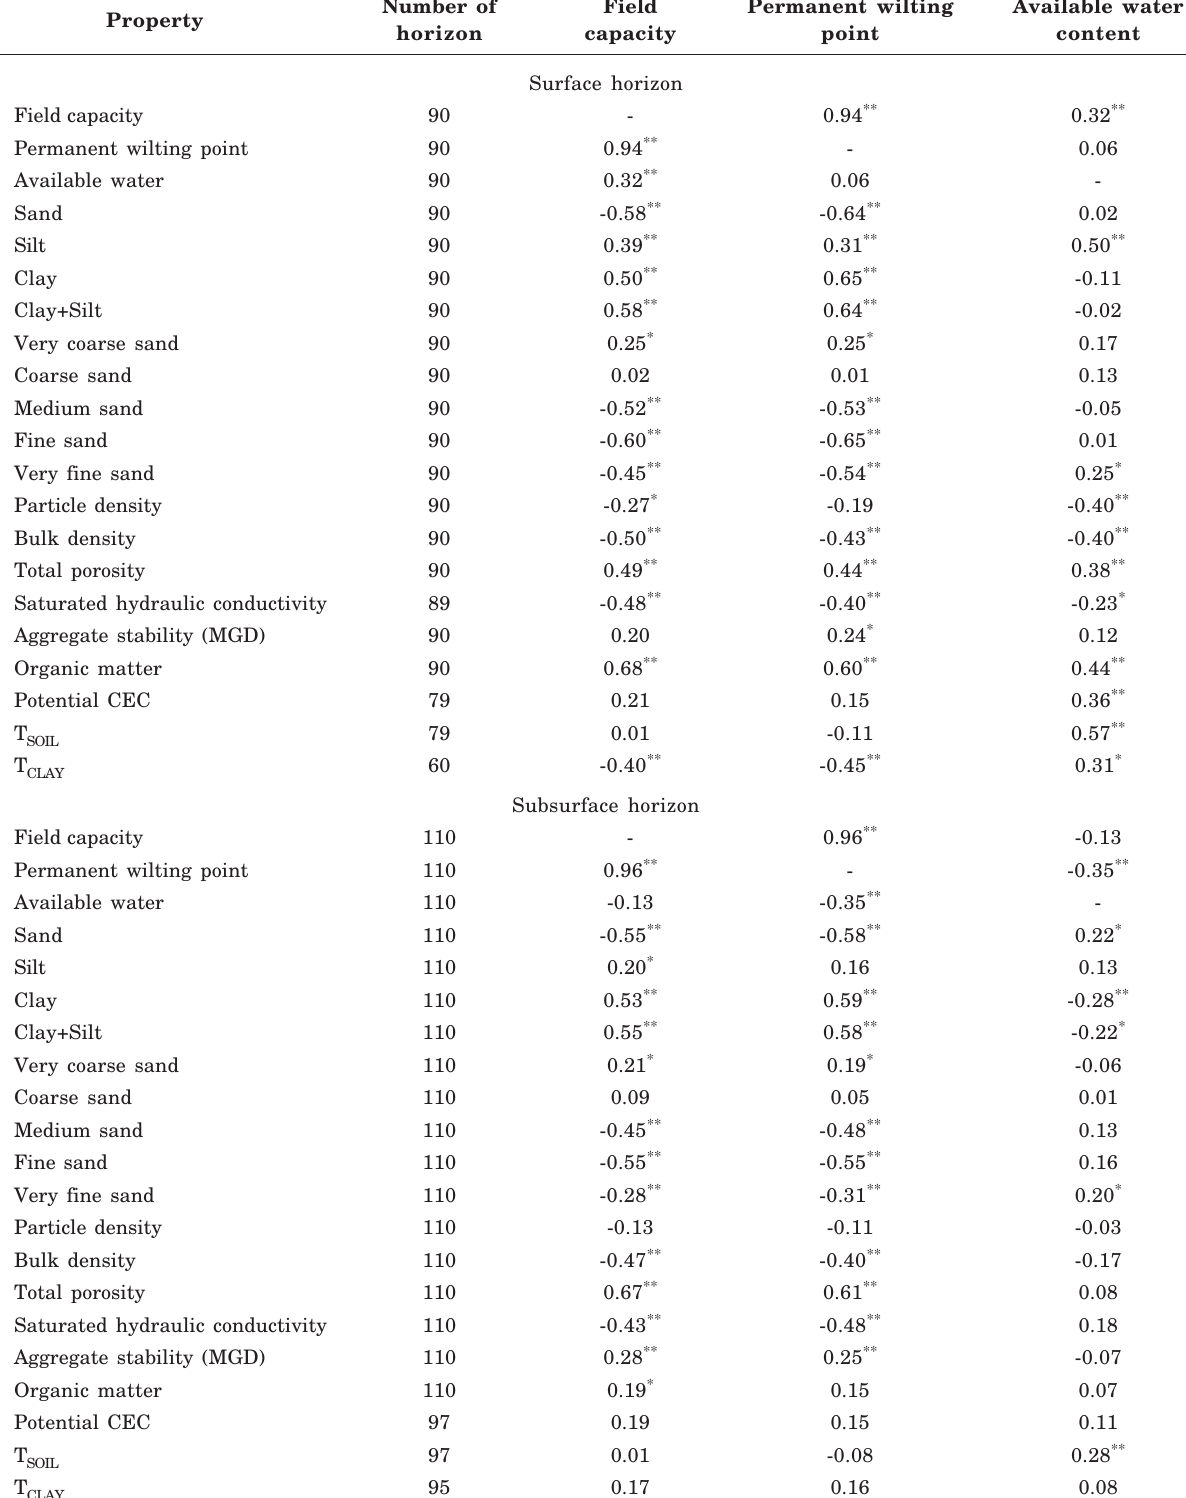
Table 2. Spearman’s rank correlation coefficient ( ρρρρρ ) between different soil properties and field capacity, permanent wilting point and available water content in surface and subsurface horizons of different soil profiles in the State of Santa